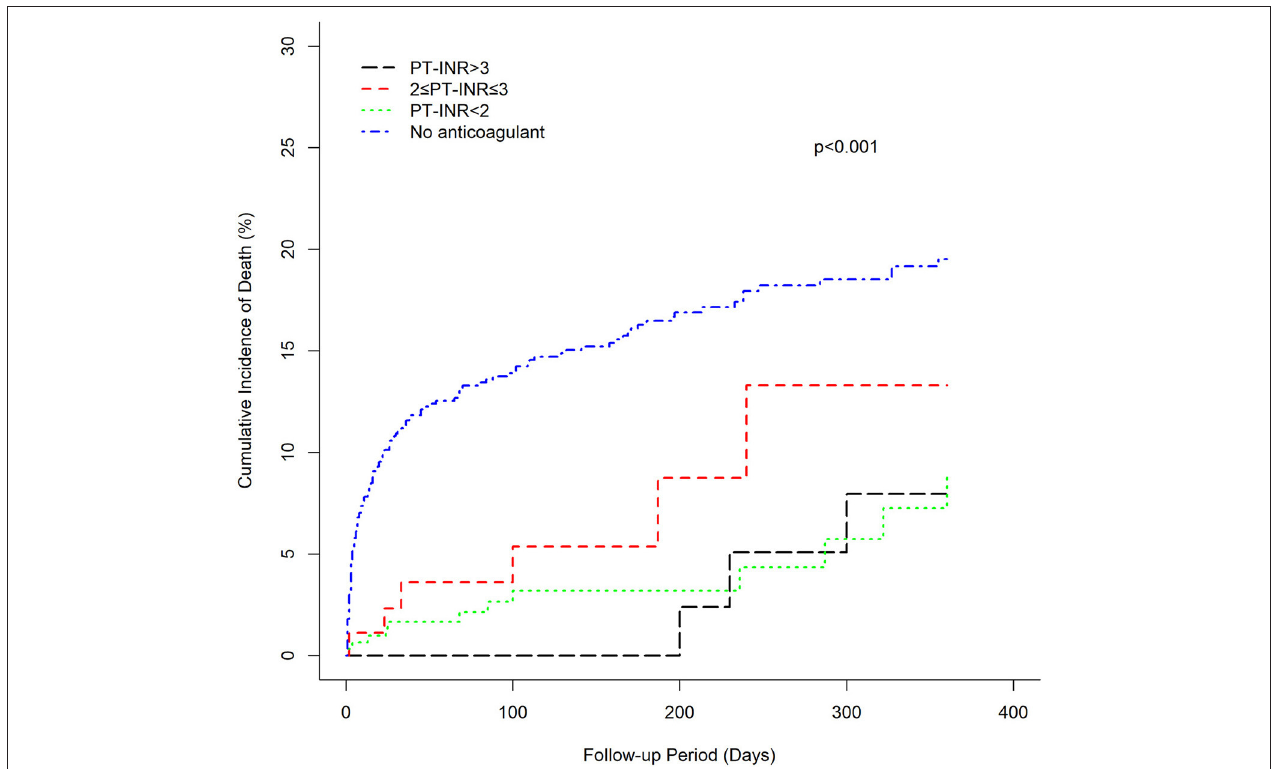
FIGURE 1 | Cumulative mortality of warfarin groups and the anticoagulant-untreated group (PT-INR).